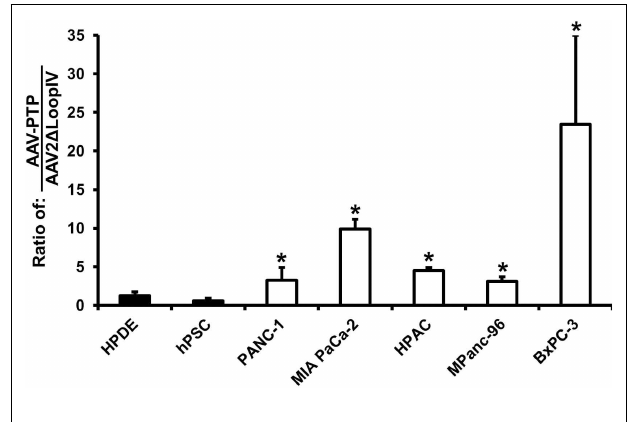
FIGURE 1 |AAV-PTP preferentially targets human PDAC cells over non-PDAC cells in vitro . Two non-neoplastic human cell lines: HPDE (immortalized human pancreatic ductal epithelial cells) and hPSC (immortalized human pancreatic stellate cells) and five human pancreatic cancer cell lines (PANC-1, MIA PaCa-2, HPAC, MPanc-96, and BxPC-3) were either mock-transfected or transfected with identical reporter genomes packaged in the AAV2 capsid, negative control capsid (AAV2 ∆ LoopIV), or the plectin-1 targeted capsid (AAV-PTP). Luciferase signals were imaged using an IVIS Spectrum and quantified using Living Image software.The results in the graph are presented as the ratio of AAV-PTP to AAV2 ∆ LoopIV after background subtraction. Asterisks (*) denote p < 0.05 vs. the mean of the two non-neoplastic control cell lines (HPDE and hPSC).